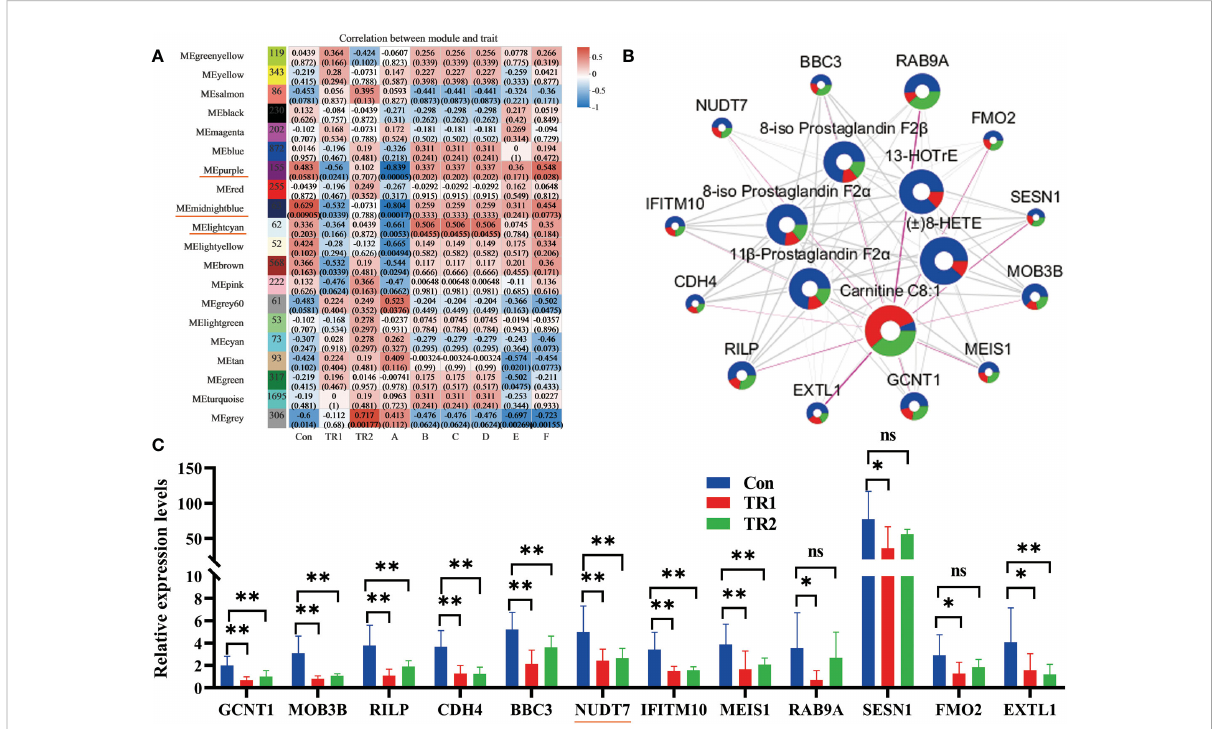
FIGURE 4 DEGs related with peroxidation of PUFAs. Module analysis of DEMs related with PUFAs metabolism and all fi ltered genes (Underlined modules in red represent selective modules; A, carnitine C8:1; B, 8-iso-prostaglandin F2 a ; C, 11 b -prostaglandin F2 a ; D, 8-iso-prostaglandin F2 b ; E, (±) 8-HETE; F, 13-HOTrE) (A) , network map analysis of selective twelve DEGs and DEMs related with PUFAs metabolism (circle size represents absolute log 2 FC (Con vs TR1) value; blue, red and green divisions in every circle are on behalf of contents of some DEGs or DEMs in Con, TR1, TR2 in turn; The thickness of the connecting wire represents the degree of connectivity) (B) and the relative expression levels of selective twelve target DEGs in three groups (*represents p <0.05, ** represents p <0.01, ns represents no differences) (C)